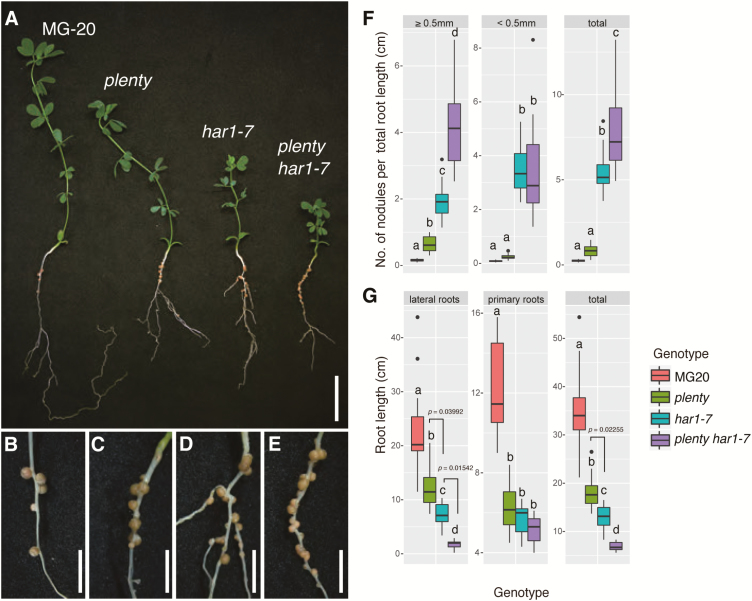
Additive nodulation of the plenty har1-7 double mutant. (A) Nodulation in the wild-type (MG-20), plenty, har1-7, and plenty har1-7 double mutant plants. (B–E) Magnified images of nodulated roots of the wild type (MG-20) (B), plenty (C), har1-7 (D), and the plenty har1-7 double mutant (E). (F) Boxplot of the nodule number [≥0.5 mm diameter (left), <0.5 mm diameter (middle), total (right)], normalized by the total root length of each plant, counted at 21 DAI with M. loti MAFF303099. (G) Boxplot of the lengths of lateral loots (left), primary roots (middle), and total roots (right) of each plant, measured for normalization in (F). Scale bars=2 cm in (A) and 5 mm in (B–E). The values of the total nodule numbers were used for the statistical analysis in (F). Different lower case letters represent statistically significant differences (P<0.05; Tukey’s HSD; n=14). 0.01<P<0.05 are denoted on the graph. The black dots represent outliers. Experiments were performed in triplicate (n≥10 in each trial).